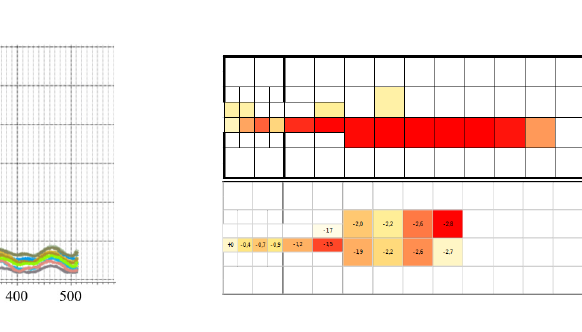
Figure 2. Signal amplitudes for a given event on the di ff erent pads (left), and 2D (top) and 3D (bottom) tracks reconstruction for two proton events generated by 1MeV neutrons (right). The values on the 3D track reconstructions are expressed in cm and represents the proton evolution in the z-axis.